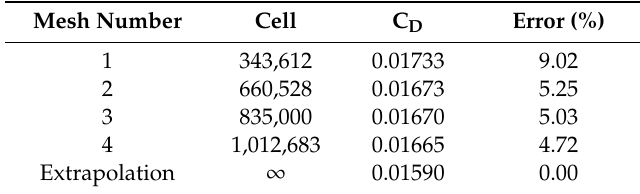
Table 6. Mesh convergence study for the cruise configuration in SU2 ( α = 0 deg, M = 0.85). Mesh number